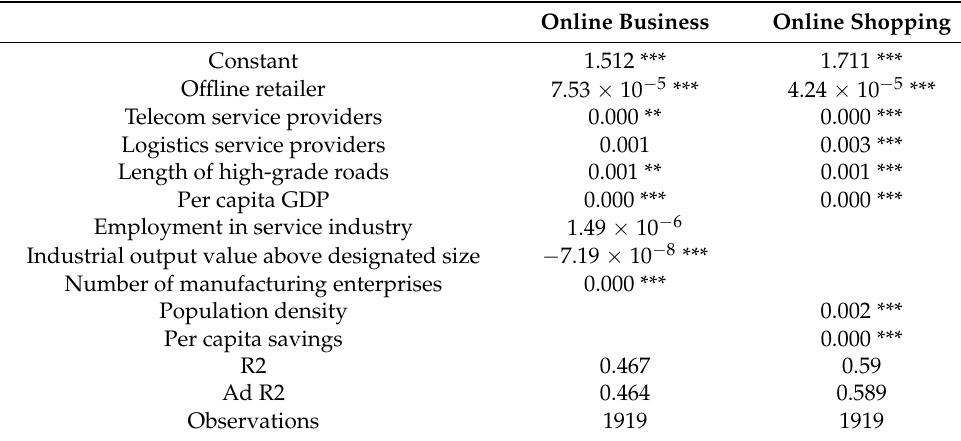
Table 2. Ordinary least squares (OLS)